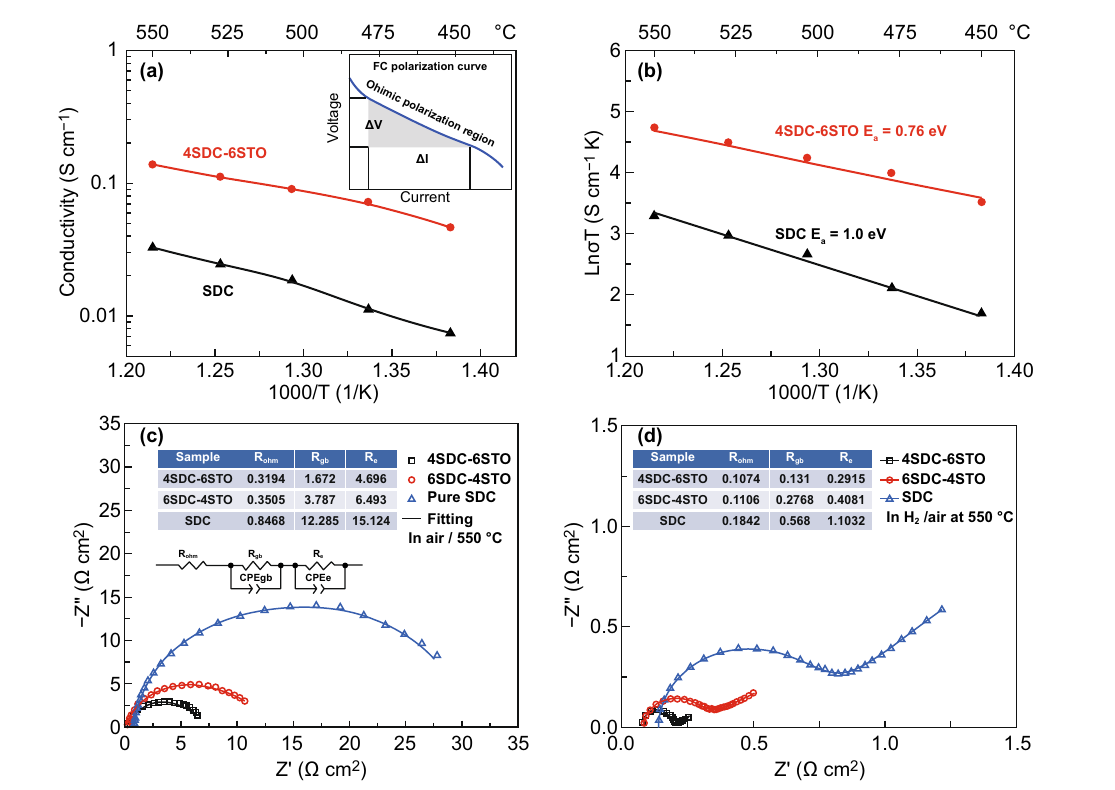
Fig. 5 a Ionic conductivity and b activation energy plots of 4SDC–6STO and SDC as a function of 1000/T obtained from I–V polarization curves from 450 to 550 °C. Impedance spectra of c SDC, 6SDC–4STO, and 4SDC–6STO electrolyte pellets measured in air 550 °C with the equivalent circuit model for fitting. d Three fuel cells based on pure SDC, 6SDC–4STO, and 4SDC–6STO measured in H 2 /air 550 °C (inset: simulated